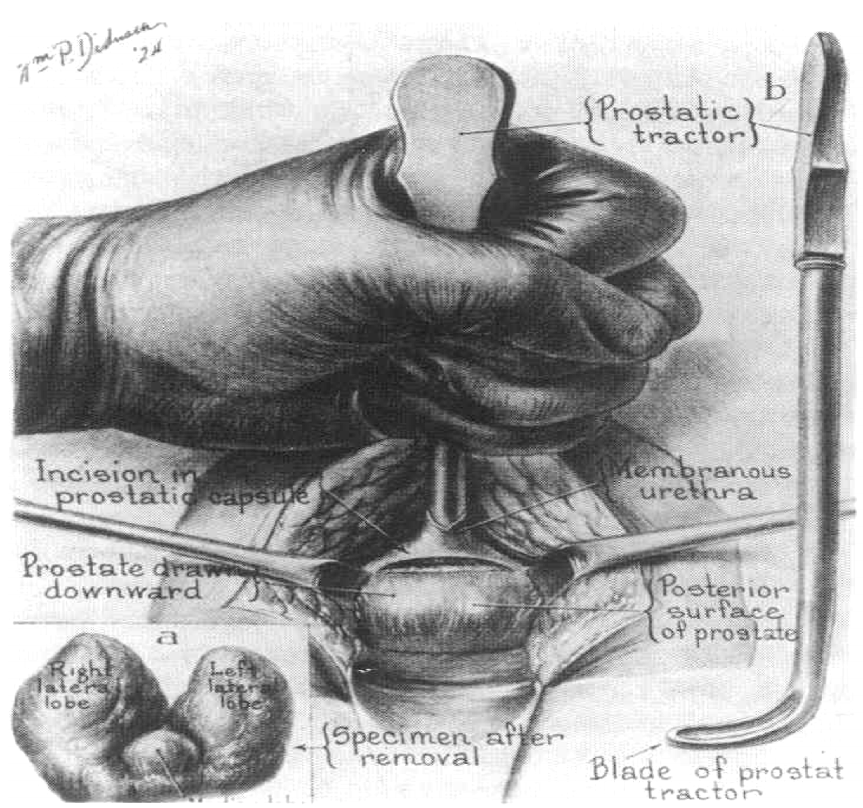
Figure 1 – Dr. Young’s original depiction of prostatic tractor used for enucelation of the hypertrophied lobes of the prostate